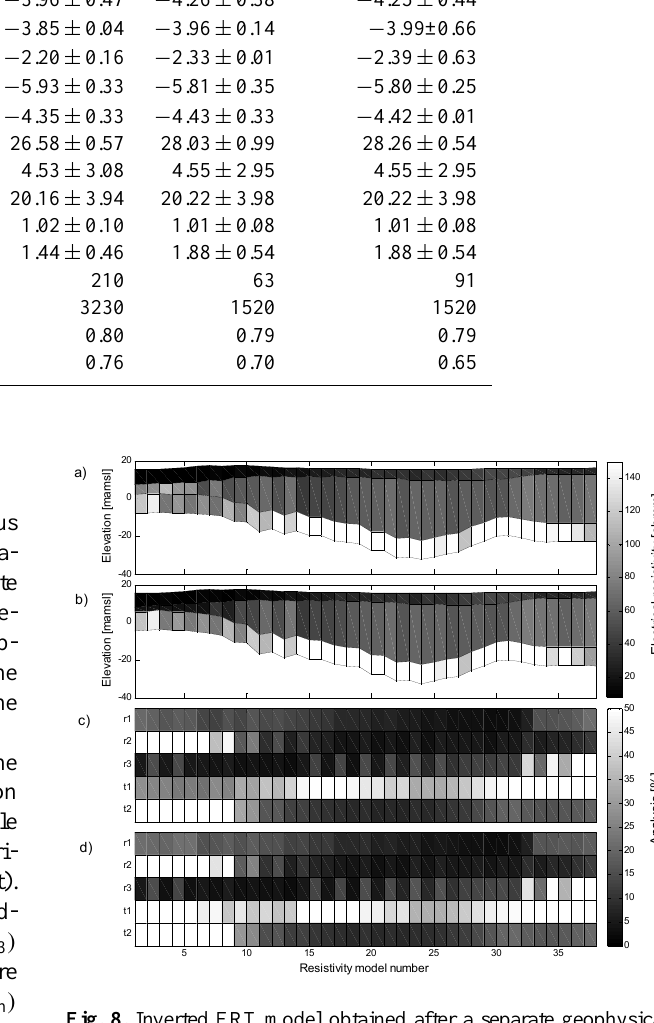
Fig. 8 Inverted ERT model obtained after a separate geophysical inversion (a) and using the JHI with e c =0.2 (b) together with a 2 Fig. 8. Inverted ERT model obtained after a separate geophysical parameter uncertainty analysis expressed by their standard deviation relative to the parameter estimate. A gray scale marks well (dark 3 inversion (a) and using the JHI with e c = 0.2 (b) together with a pa- colored) and undetermined parameters (light colored) for the separate geophysical inversion (c) and a JHI with e c =0.2 (d). 4 rameter uncertainty analysis expressed by their standard deviation 5 relative to the parameter estimate. A gray scale marks well (dark colored) and undetermined parameters (light colored) for the sepa- rate geophysical inversion (c) and a JHI with e c = 0.2 (d)